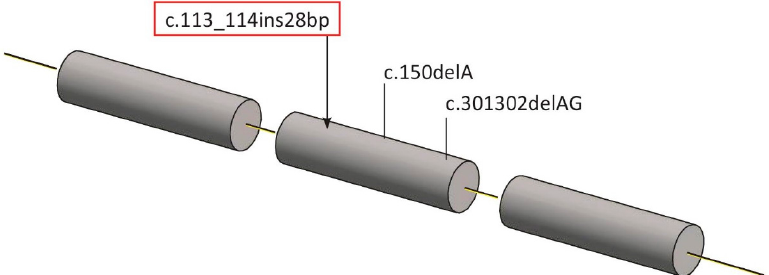
Figure 2. Scheme describing the PROP1 gene with points of the common mutations (301_302delAG and c. 150delA) and the region of the novel identified mutation.